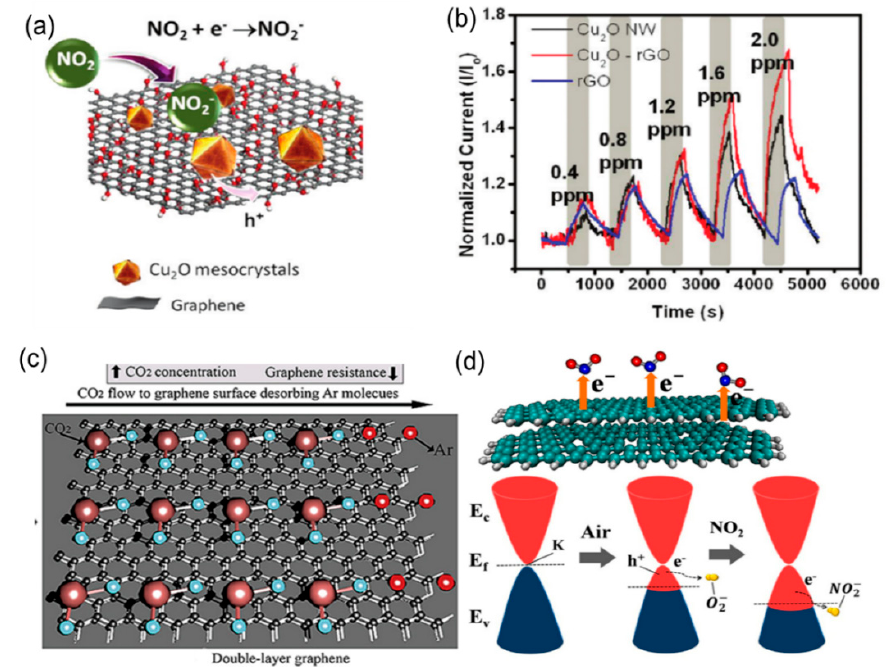
Figure 2. ( a ) Schematic diagram of Cu 2 O–rGO sensing mechanism for NO 2 . ( b ) Relative current changes of Cu 2 O NW, rGO–Cu 2 O, and rGO based devices when exposing to different concentrations of NO 2 [32]. Copyright (2021), used with permission from the American Chemical Society. ( c ) Schematic diagram of carbon dioxide adsorption/desorption with argon purging the graphene surface [33]. Copyright (2018), used with permission from Elsevier. ( d ) Schematic diagram of the sensing mechanism and energy band change of the charge transfer between the double-layer graphene gas-sensitive material and NO 2 [34]. Copyright (2017), used with permission from Elsevier.